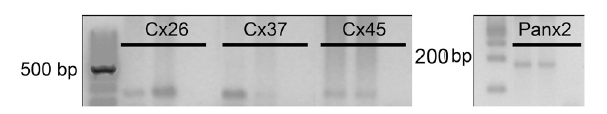
FIGURE 4 | Presence of Cxs 26, 37, 45, and Panx2 in NPJcs. mRNAs of Cxs 26, 37 and 45 and Panx2 were detected in total RNA extracted from rat NPJcs and in RT-PCR analyses. The primers used are listed in Table 1 .